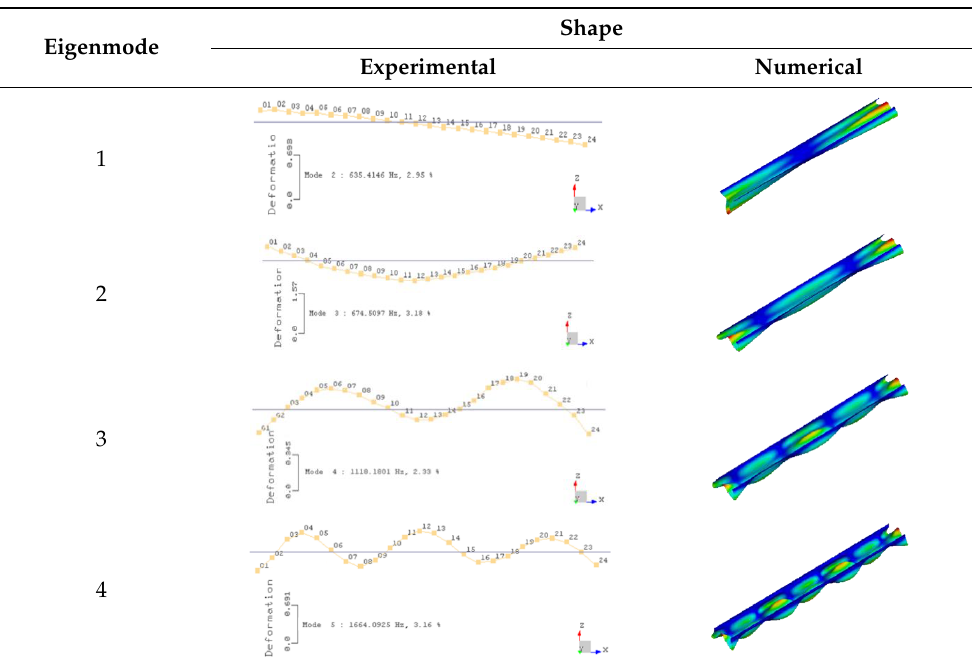
Figure 8. Modal Assurance Criterion (MAC) matrix comparing the results from the experimental and numerical approaches. Additionally, Table 3 displays the values of the dynamic Young’s modulus that were obtained by inverse engineering using an updating approach (i.e., correlating experi- mental and numerical eigenfrequencies with the Young’s modulus as a variable). Com- paring these values with those calculated for the cantilever approach (Table 2), it is deter- mined these tend to slightly increase (i.e., increase stiffness) as frequency is also increased. 3.3. Considerations on the Method for the Determination of Dynamic Young’s Modulus It has been established that acoustic pressure may be successfully used to excite sam- ples with low stiffness and low mass, and Laser Döppler Vibrometry is an efficient route